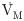
Comparison of viral infection effects on HVR (A) and HCVR (B) among Ctrl, HK483, and HK486 mice.HVR and HCVR were measured daily in individual mouse at 2 and 1 days before and 1, 2, and 3 days after intranasal inoculation (Day -2, -1, 1, 2, and 3). V˙M, minute ventilation; fR, respiratory frequency; and VT, tidal volume. Mean ± SE. n = 6, 15, and 7 for Ctrl, HK483 and HK486 mice. * P < 0.05 compared to the data obtained in previous day(s) and † P < 0.05 compared to Ctrl and HK486 mice at the same time-point. HK483 rather than HK486 viral infection produces HVR and HCVR depression at 2 and 3 dpi.